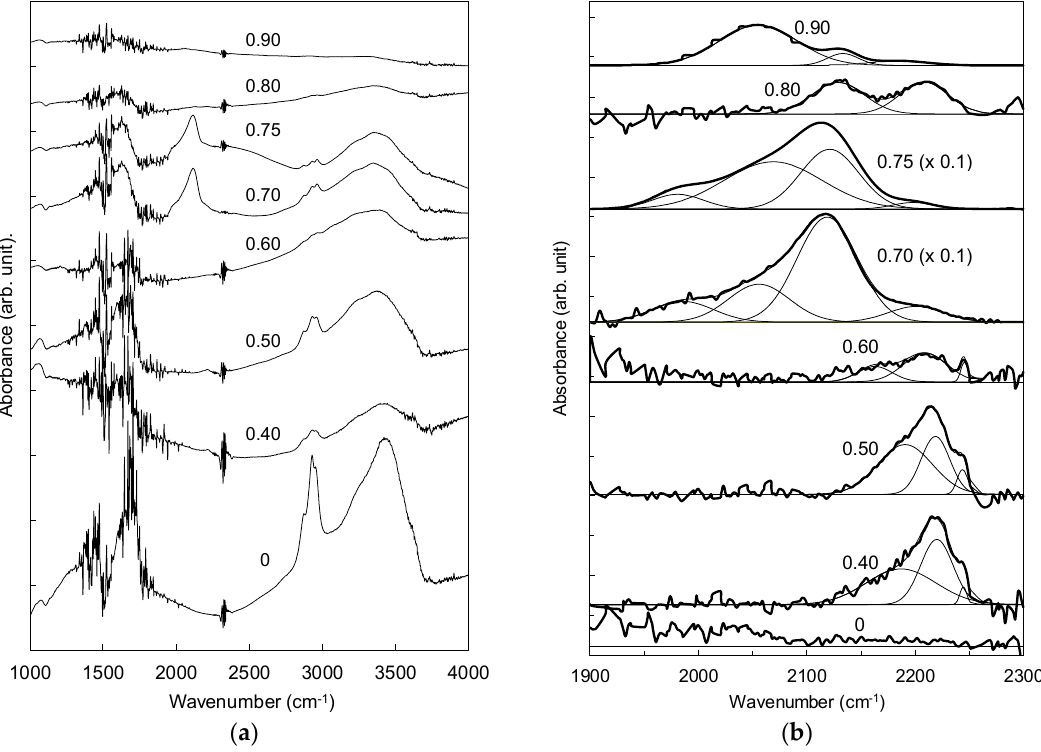
Figure 7. Variation of Fourier transform of infrared spectroscopy (FTIR) in the range of ( a ) 1000–4000 cm − 1 and ( b ) 1900–2300 cm − 1 . The deconvolution for nitrile and isonitrile bonds are shown in (b).